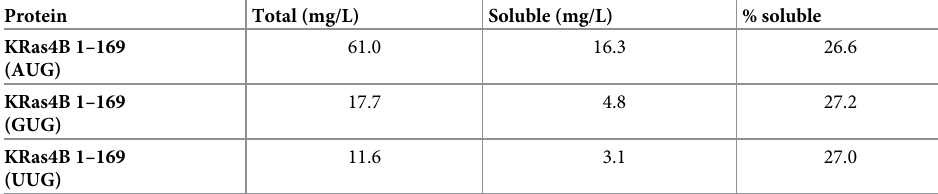
Table 3. Milligram per litre yields and soluble partitioning from KRas expressions from different cognate start codons. Protein Total (mg/L) Soluble (mg/L) % soluble